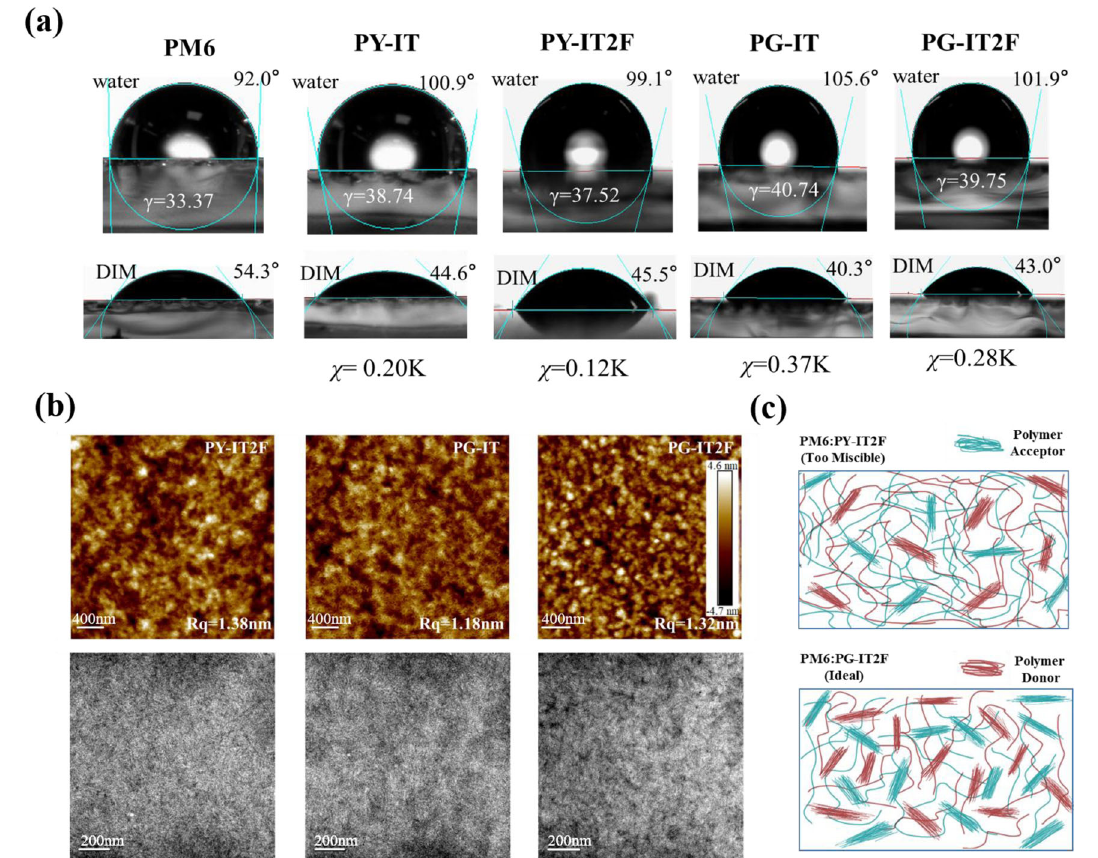
Fig. 4 | Contact angles and morphologies. a Contact angles of PM6, PY-IT, PY- IT2F, PG-IT, and PG-IT2F and the corresponding Flory-Huggins interaction para- meters. b AFM height images and TEM images of PM6:PY-IT2F, PM6:PG-IT, and